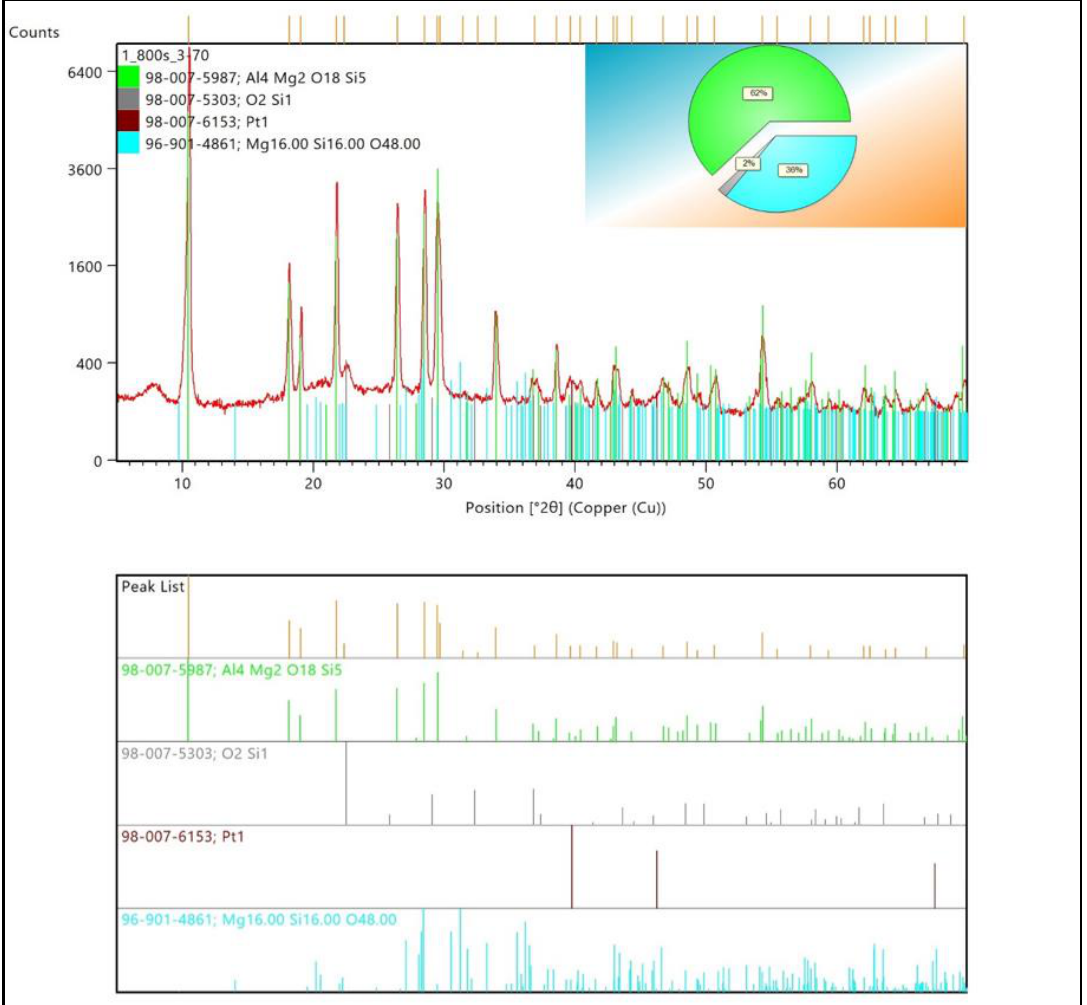
Figure 3. X-ray diffraction patterns of the spent automotive converter.